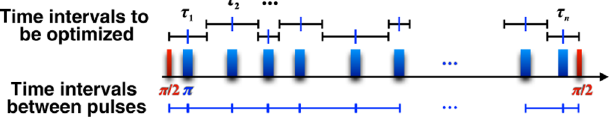
FIG. 5. NV spin coherence under the CP sequence. Measured signal s ð T Þ (gray dots) after a CP decoupling sequence with n ¼ 50 , as a function of time T ¼ n τ . Here, the sensor is not irradiated with any external target field b ð t Þ to be measured. The solid red line is a fit of the signal based on a classical model of the bath (see text).